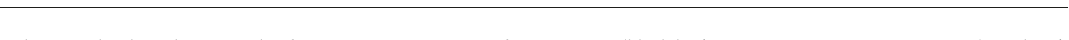
Fig. 3 Endogenous NO synthesis and Zeb1-Hdac2 complex formation. a cGMP quanti fi cation in GS (black bar), in DM ± PTIO, ODQ, L-NAME (gray bars) for 1, 2, or 3 h and in NO ± PTIO (white bars) for 24 h. ( n = 3; * p < 0.05 DM vs. GS; ° p < 0.05 treatments vs. DM). b Zeb1-chromatin binding analysis on: Wnt3, Wnt7b, Tbx4, Dll1, and Mesp2. Chromatins extracted in DM (gray bars) or DM + PTIO (striped bars). Data compared to IgG value (striped bars) after Input normalization ( n = 3). c Left panel: representative immunoprecipitation (IP)/western blotting (WB) analysis of Hdac2 S-nitrosylation in GS (24 h), DM or NO (2 h). Right panel: densitometry ( n = 3; * p < 0.05 NO vs. DM). Full-length blot provided in Supplementary Fig. 9a. d Reciprocal co-IP analysis showing Zeb1:Hdac2 (left) and Hdac2:Zeb1 (right) complex formation in GS, DM or NO (24 h; n = 3 each group). Full-length blot provided in Supplementary Fig. 9b and c. e Left panel: representative co-IP analysis showing Zeb1:Hdac2 wt and Zeb1:Hdac2 C262A/C274A complex formation compared to empty vector (Ev)-transfected HeLa cells. HeLa transfected with Ev or co-transfected with pCMV6_Zeb1/pCIG2_Hdac2 wt or pCMV6_Zeb1/ pCIG2_Hdac2 C262A/C274A . Right panel: densitometry ( n = 3; * p < 0.05 Zeb1:Hdac2 wt vs. Ev; ° p < 0.05 Zeb1:Hdac2 C262A/C274A vs. Zeb1:Hdac2 wt ). Full- length blot provided in Supplementary Fig. 9d. f Left panel: representative WB analysis of eNOS, nNOS, and iNOS in GS or DM ( n = 3). Loading control: α - tubulin. Full-length blot provided in Supplementary Fig. 9e. Right panel: eNOS, nNOS, and iNOS mRNA analysis in GS (black bars) or DM (gray bars). Data expressed as fold increase of GS after subtraction of the housekeeping gene p0 signal ( n = 3; * p < 0.05 DM vs. GS). g Zeb1-chromatin binding analysis on eNOS promoter in GS (black), DM (gray), and NO (white). Data represented as fold increase of GS after input normalization ( n = 3). h , i eNOS mRNA expression analysis in GS, DM, and NO prior (control vector LCv2_NTC; black bar) and after CRISPR/Cas9 inactivation of Zeb1 ( h ; LCv2_Zeb1_1/_2; gray bars) or CRISPR/Cas9 inactivation of Hdac2 ( i ; LCv2_Hdac2_1/_2; white bar). Data represented as fold increase compared to control after subtraction of the housekeeping gene p0 signal ( n = 3; * p < 0.05 LCv2_Zeb1_1/_2 or LCv2_Hdac2_1/_2 vs. LCv2_NTC). Data represented as mean ± s.e.m. and